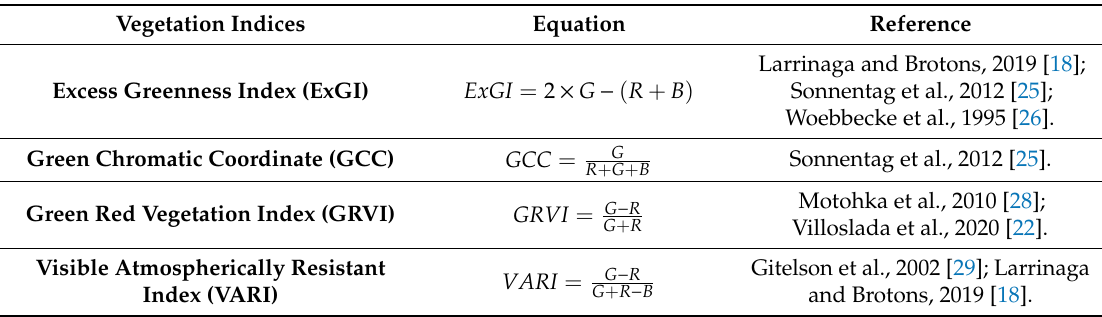
Table 2. Vegetation indices selected in the present study. Vegetation indices were used to assess their potential to discern di ff erent morphological zones within the Cwm Ivy Marsh